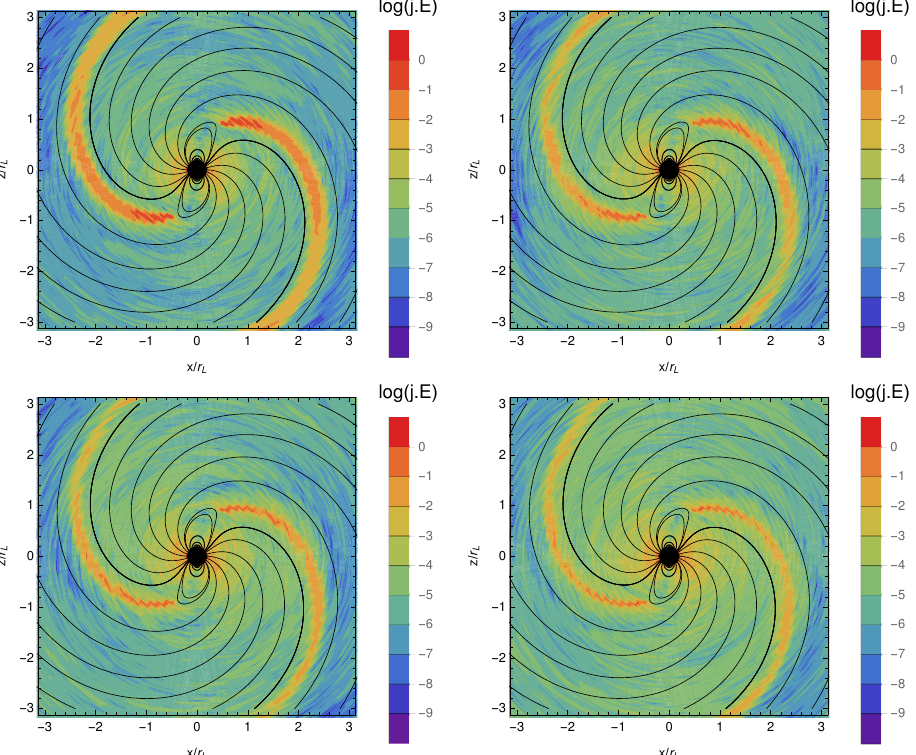
Figure 5. Dissipation in the equatorial plane of an orthogonal rotator for κ = { 0,1,2,5 } (from left to right , top to bottom